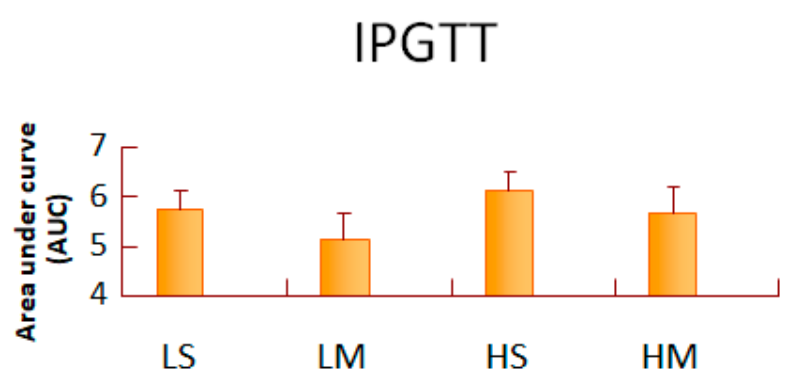
Figure 1. Area under the curve (AUC) of intraperitoneal glucose tolerance test (IPGTT) of type 2 diabetes mellitus rats fed the different diets for 8 weeks. Data are expressed as mean ± SEM ( n = 8).